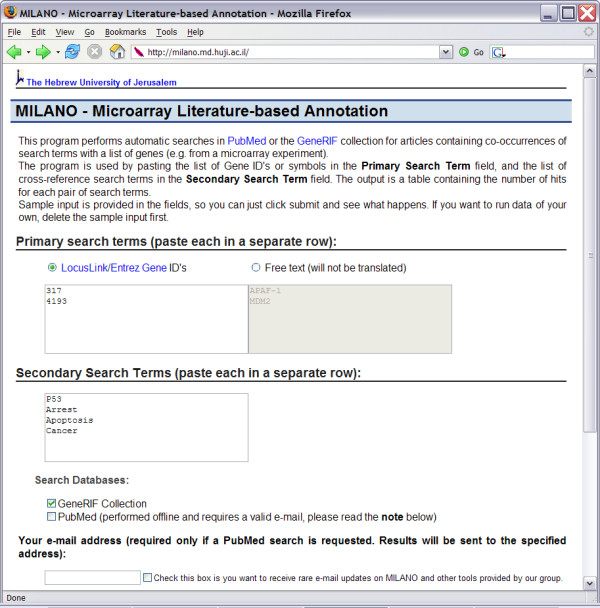
The MILANO data input page .